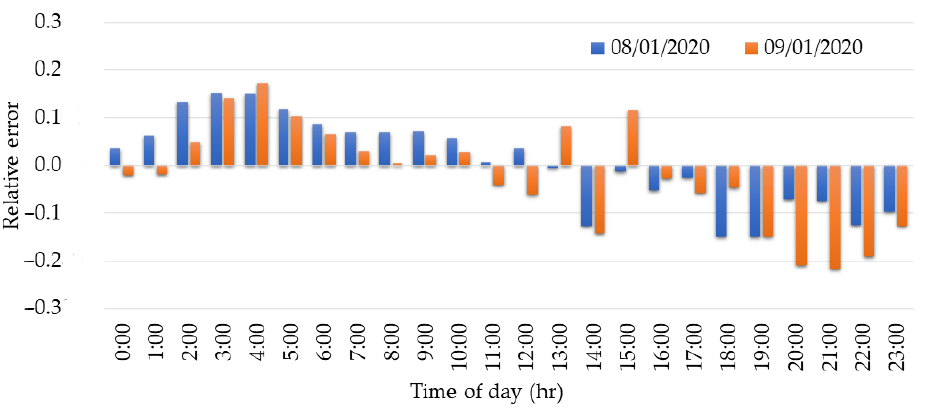
Figure 9. Relative error between predicted PM 2.5 concentrations and those observed on 8 January and 9 January 2020, showing the accuracy of the developed method as a function of time.